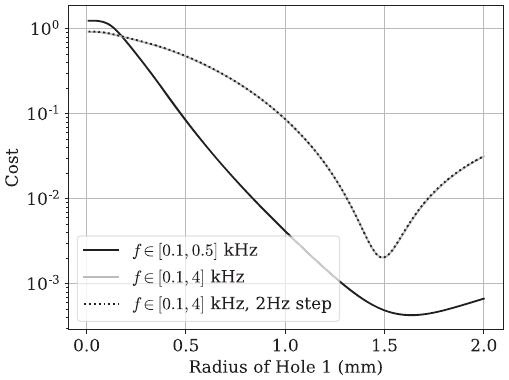
Figure 7. Cost evolution with respect to the radius of Hole 1 on the fi ngering “ oxxx ” , with three frequency ranges: [0.1, 0.5] kHz and [0.1, 4] kHz with a 100 Hz step, and [0.1, 4] kHz with a 2 Hz